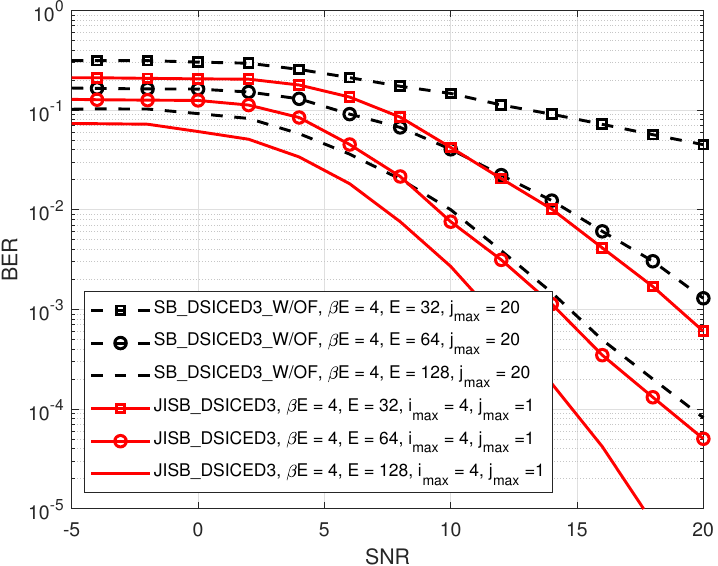
Figure 11. BER versus SNR, p B / σ 2 w ; R = 1/2, β E = 4, and p SI / σ 2 w = 30